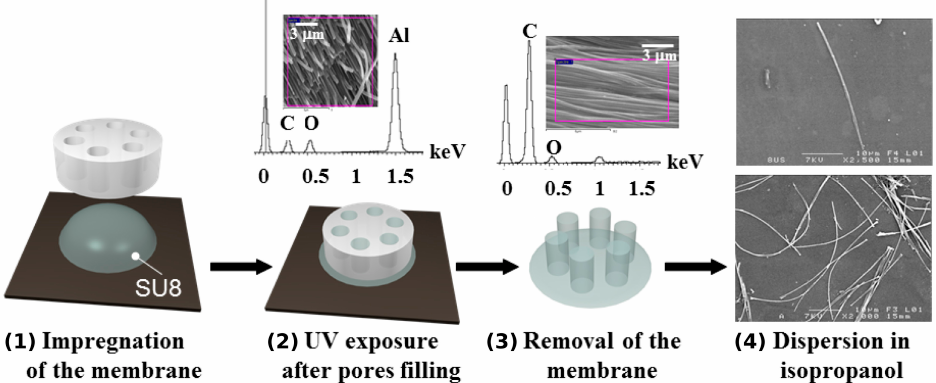
Figure 3. Illustration of the different steps of fabrication of organic nanostructures. ( 1 ) Deposition of the membrane on a drop of SU8 photoresist for membrane impregnation. EDS analysis are shown before ( 2 ) and after ( 3 ) removal of the membrane. ( 4 ) SEM images after dispersion by sonication in isopropanol and drop casting on a